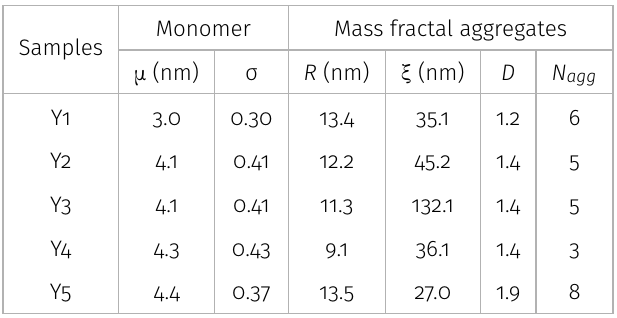
Table II. Results of SAXS data analysis of the Zn-doped magnetic